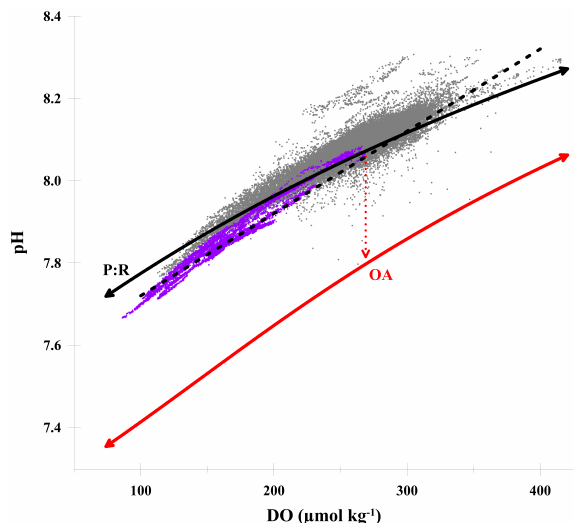
Fig. 9. Scatter plot of dissolved oxygen (DO) and pH at 7m (grey hatches) and 17m (purple hatches) water depth from all SeapHOx deployments from 10 July 2010–19 October 2011. Dashed black line is the linear relationship between pH and DO for all data regard- less of depth. Solid black line represents expected changes in DO and pH with production and respiration ( P : R ) at present-day con- ditions (384ppm CO 2 ). Future changes in pH due to ocean acidifi- cation are modeled at oxygen saturation and CO 2 levels of 800ppm (OA; dashed red line) along with the corresponding changes in the P : R relationship (solid red line).